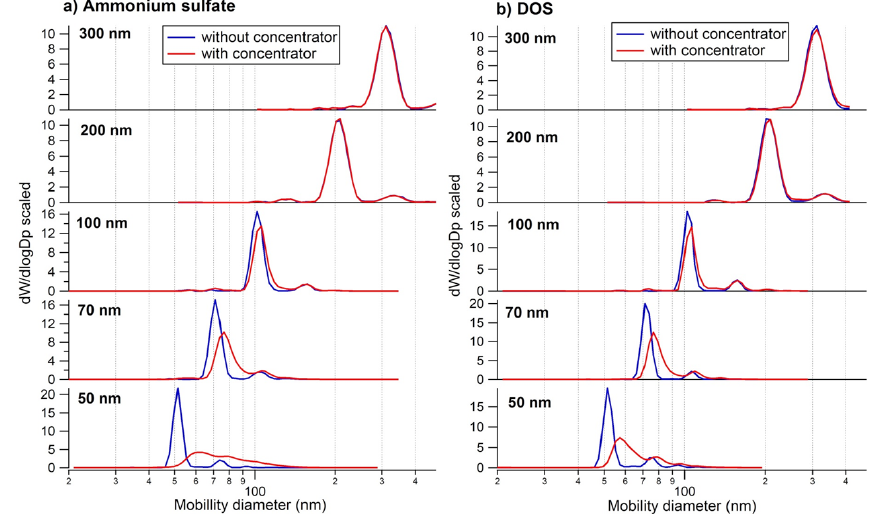
Figure 3. Number–size distributions for monodisperse AS (a) and DOS (b) . Results have been scaled according to the total number concen- trations.